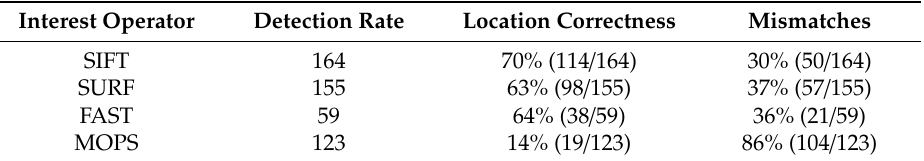
Table 1. SIFT, speeded-up robust features (SURF), features from accelerated segment test (FAST), and multi-scale oriented patches (MOPS) performance (detection rate and location correctness) in Ricoh Theta S fisheye images.